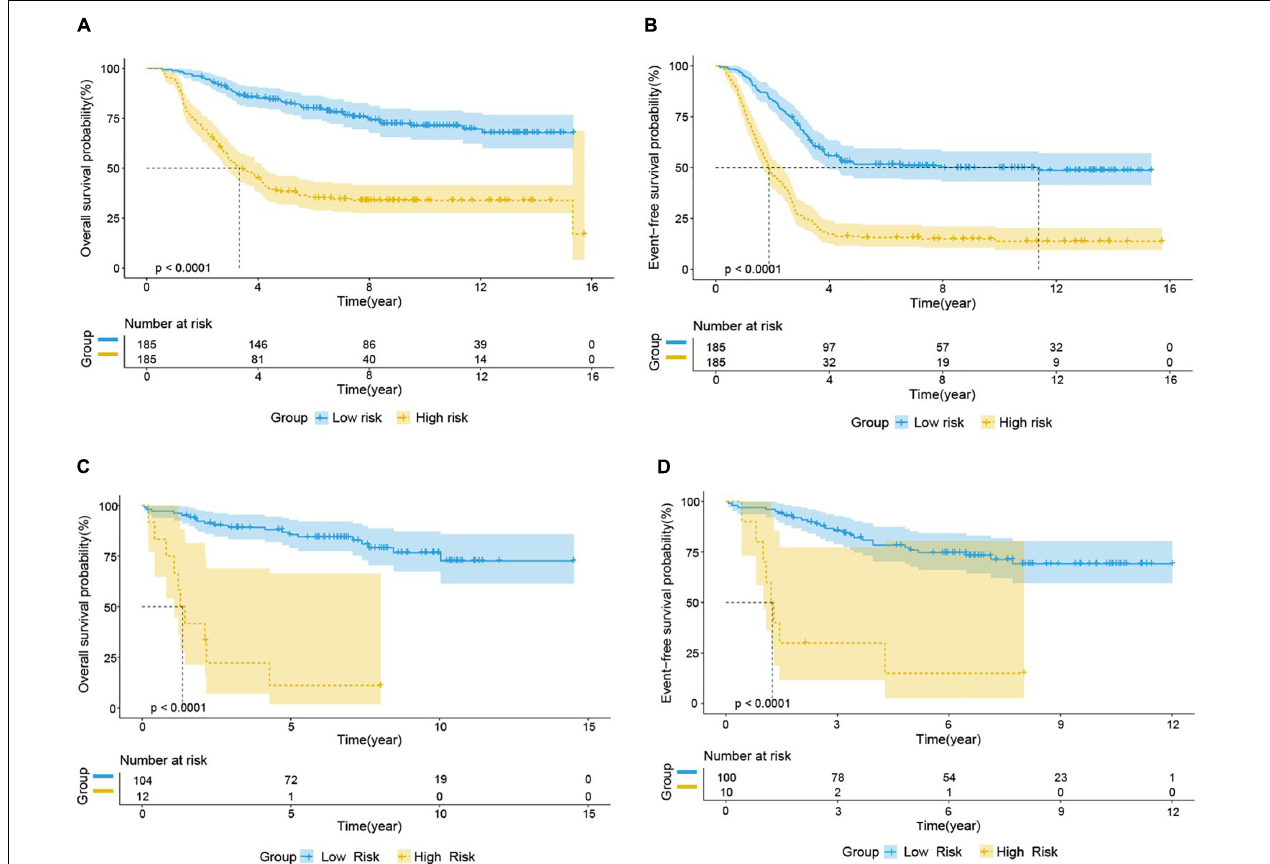
FIGURE 7 | Prognostic analysis of high-risk and low-risk group in B-ALL patients. Kaplan-Meier survival curve analysis of OS in the high-risk (yellow line) and low-risk (blue line) patients in Total Set (A) and External Validation Set (C) . Kaplan-Meier survival curve analysis of EFS in the high-risk and low-risk patients in Total Set (B) and External Validation Set (D)